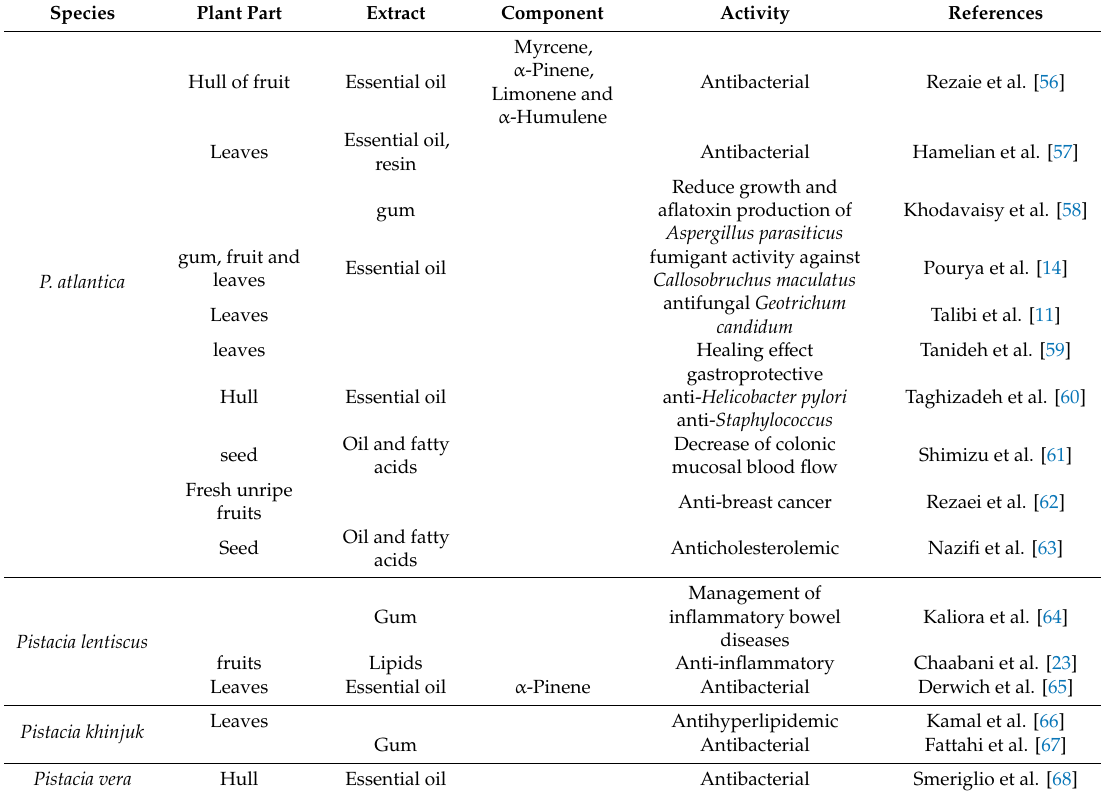
Table 4. Activities of extracts from Pistacia atlantica and other Pistacia